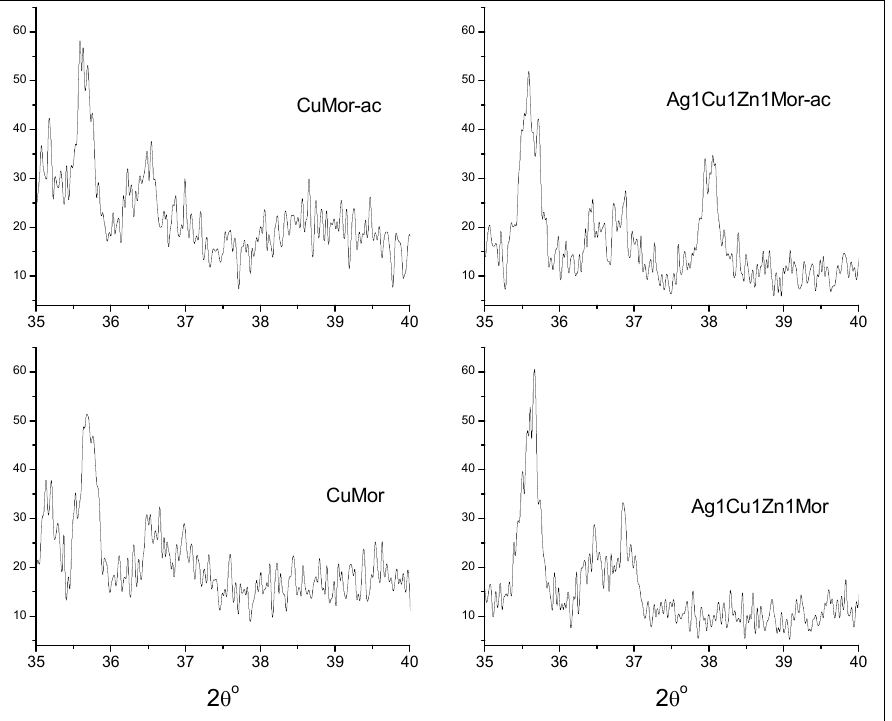
Figure 6. XRD patterns of 35–40° region of the selected samples: CuMor, CuMor-ac, Ag1Cu1Zn1Mor, and Ag1Cu1Zn1Mor-ac.